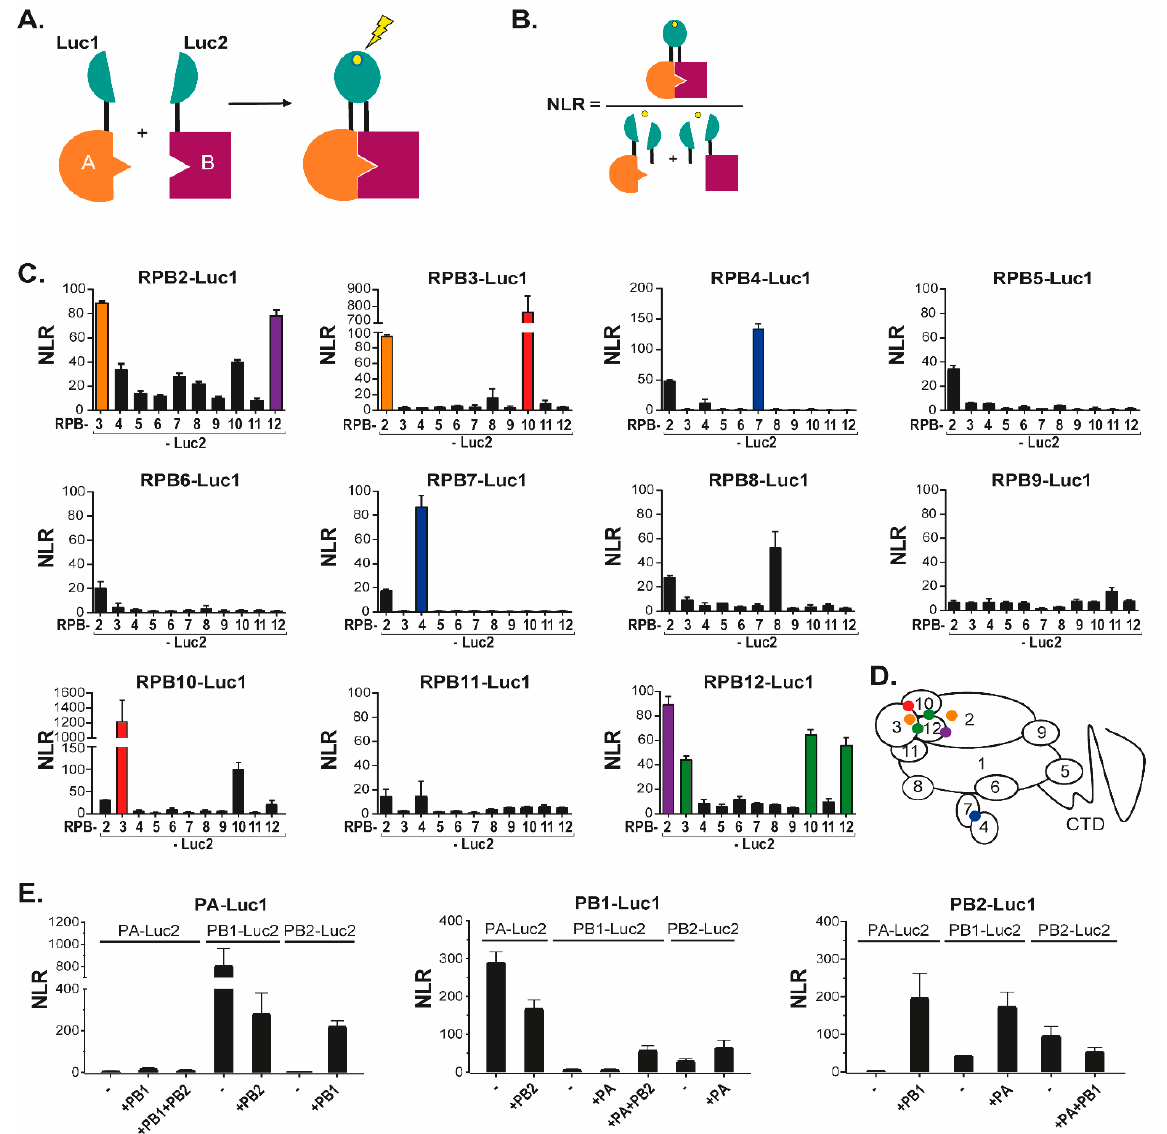
Figure 1. The split-luciferase interaction assay and its validation with Pol II and FluPol subunits. ( A ) Schematic of the principle of split-luciferase complementation assay. If protein A and protein B